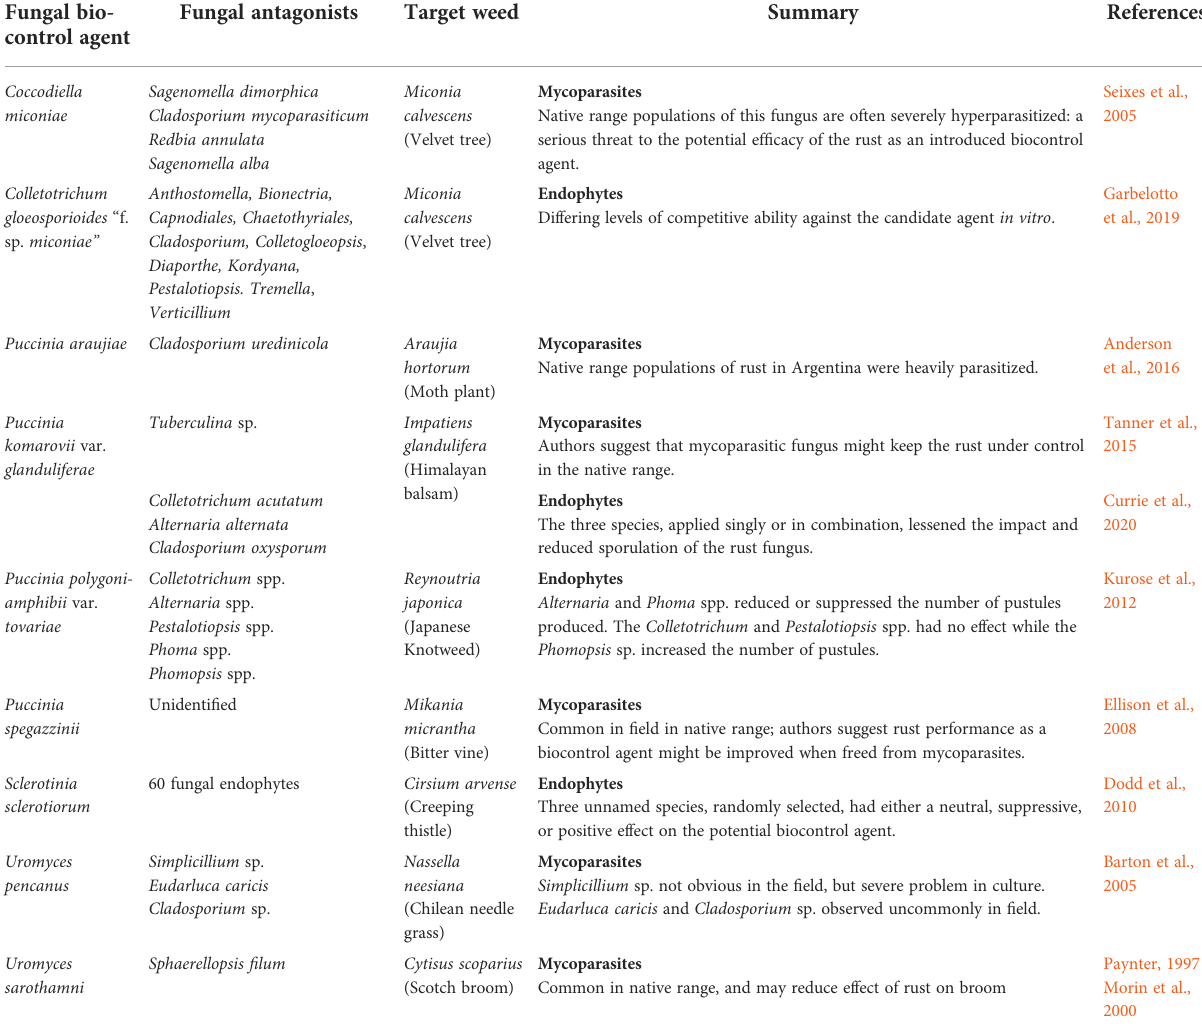
TABLE 1 Fungal antagonists, mycoparasites or endophytes, associated with introduced fungal weed biocontrol agents. Fungal bio- control